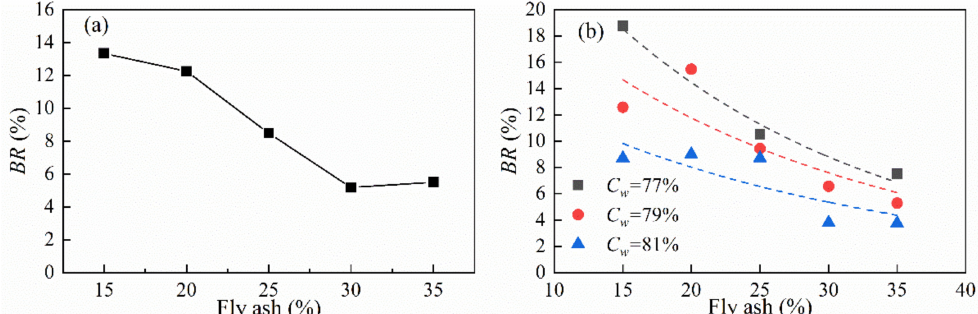
Figure 6. Relations between the BR and the fly ash content: ( a ) average BR ; ( b ) BR at varying